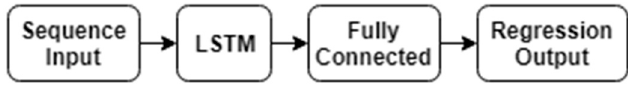
Figure 6. The architecture of the applied LSTM neural network.